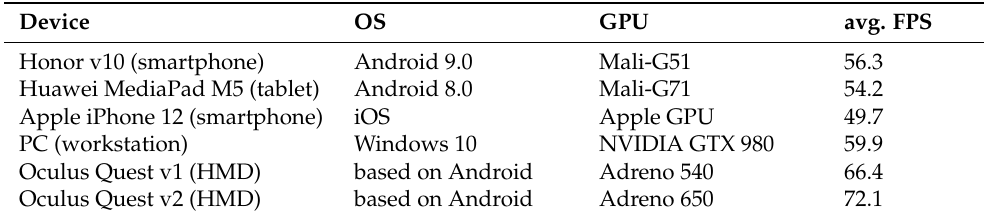
Table 3. Average framerates (4 min) for each